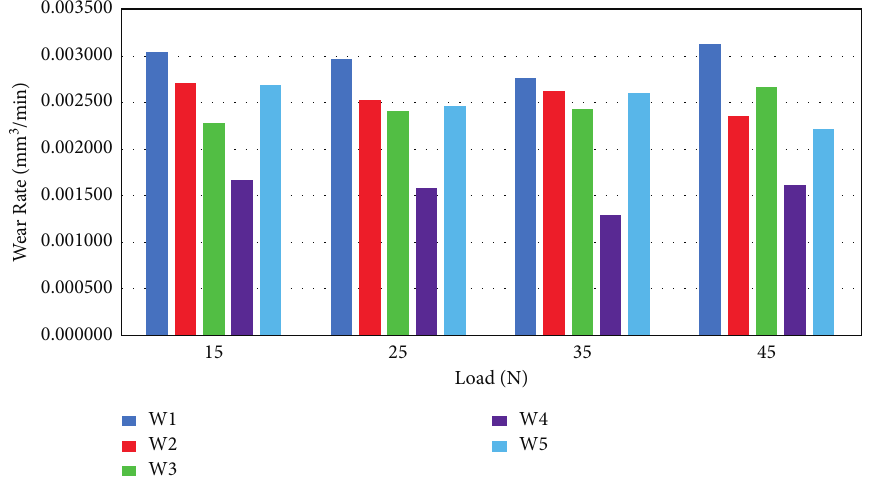
Figure 8: Variation on the wear rate of composites for 1500m sliding